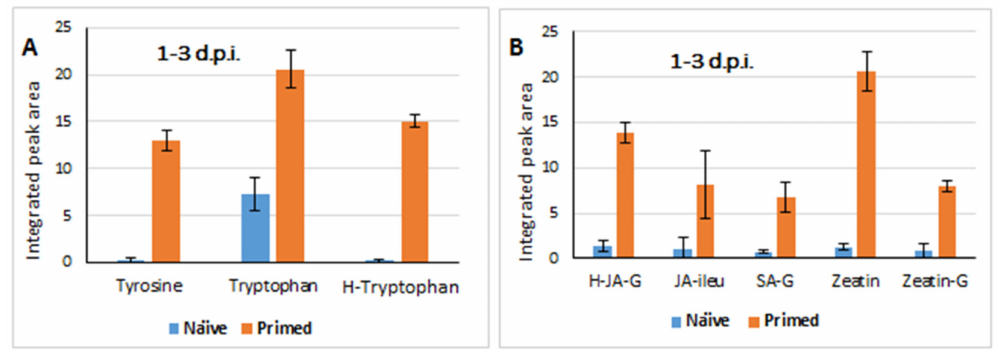
Figure 4. Quantitative profiles of amino acids and phytohormones in samples from both naïve and primed plants responding to the Colletotrichum sublineolum fungal infection. The integrated peak area of each compound (extracted from MarkerLynx-XS TM -based processing) over the time period of 1–3 d.p.i. was used for relative quantitation of the levels of the metabolites. Data represent the average of three experiments (with three replicates in each experiment), n = 45 and p -values reported as in Table 1; error bars = standard deviation. ( A ): Amino acid profiles and ( B ): Plant hormones profiles. H-JA-G = hydroxyjasmonic acid-glucoside; JA-ileu = jasmonoyl-isoleucine; SA-G = salicylate-glucoside; zeatin-G = trans -zeatin-glucoside (Table